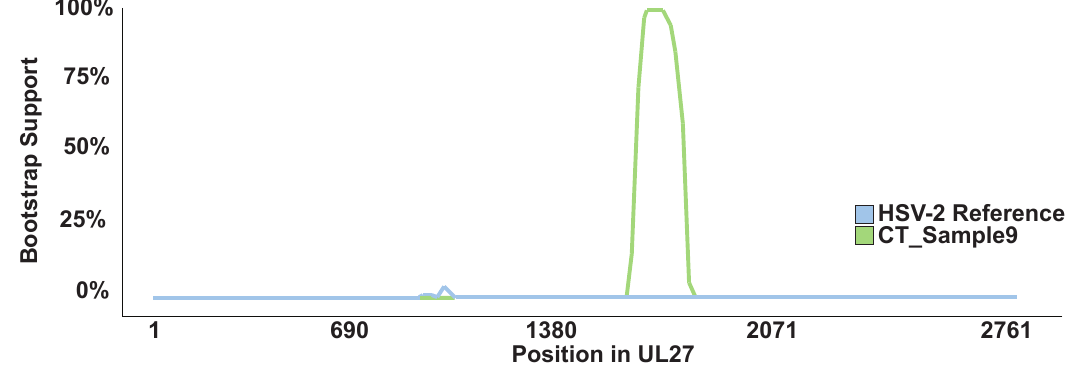
Figure 2. BootScan plot of the HSV-2 reference and CT_Sample9 sequences for UL27. The HSV-1 reference sequence is used as the query